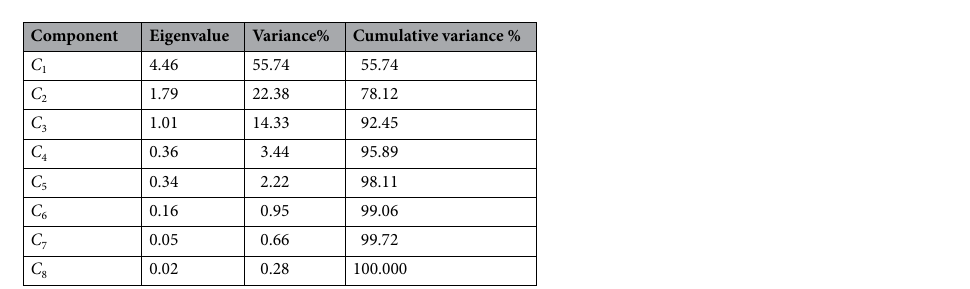
Figure 10. Correlation analysis matrix.